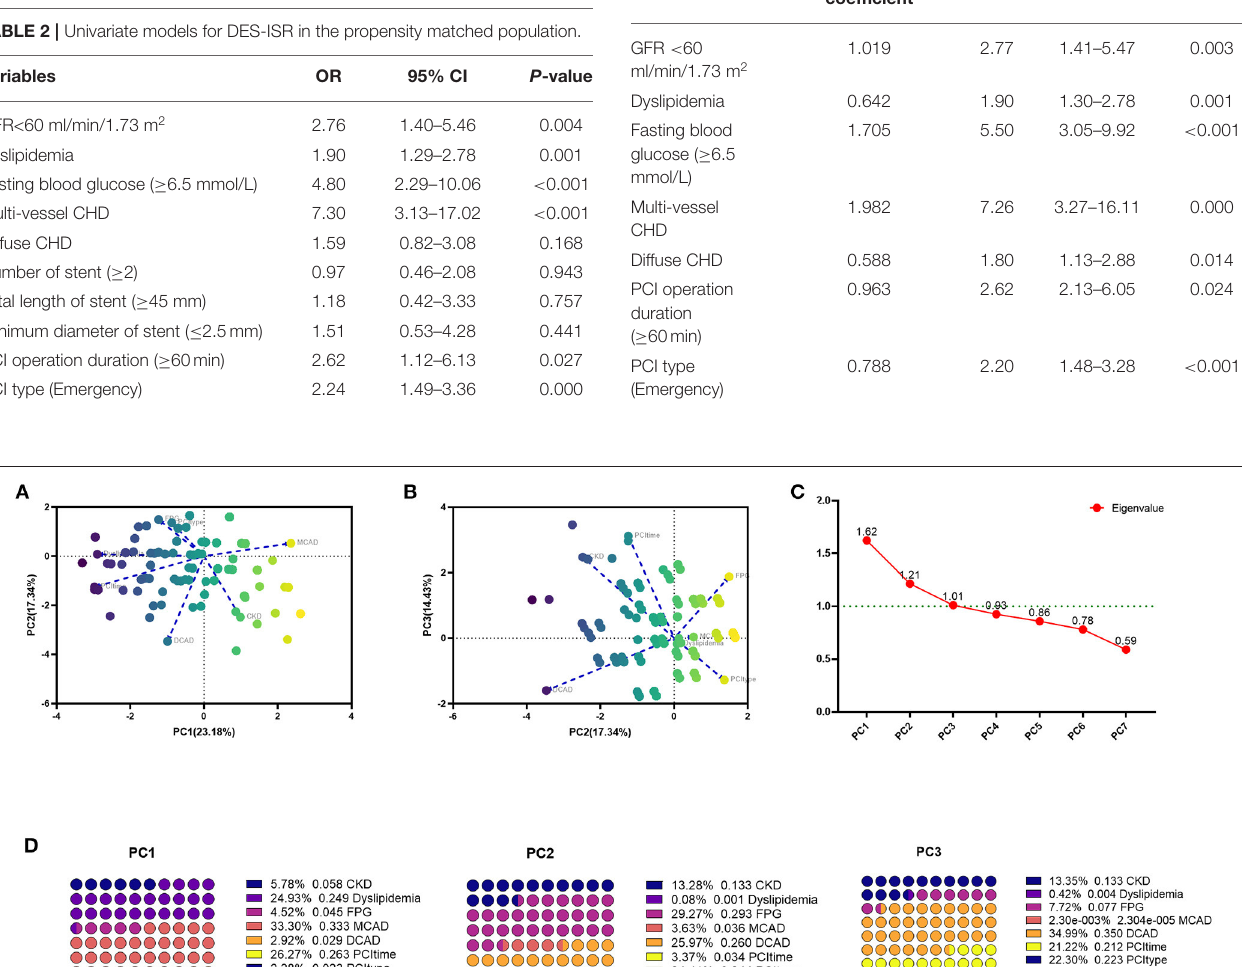
Frontiers in Cardiovascular Medicine |